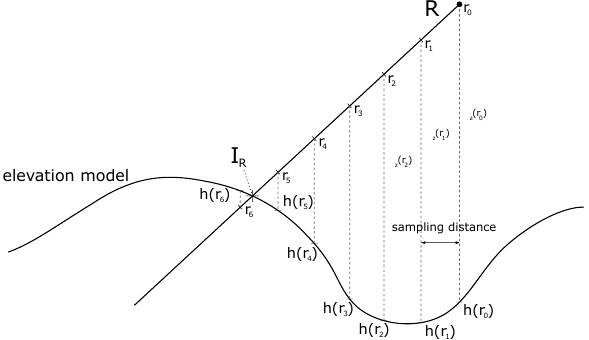
Figure 3. Determination of intersection: gradual evaluation of vertical distance between sampling points r n and its elevation h ( r n ) leads to (approximated) intersection point I R Following this algorithm, all four sensor corner rays of an aerial image can be intersected with the given elevation model. The four obtained intersection points represent a rough footprint of the images’ captured area. This geo-referenced polygon is then used for the projective mapping of the corresponding